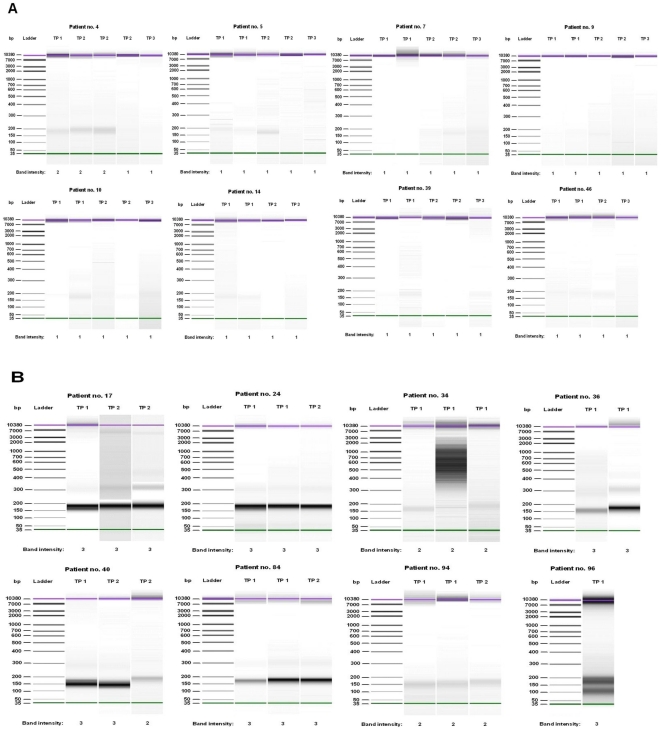
Qualitive cf-DNA analysis.Qualitative analysis of plasma cf-DNA in 8 bacteremia survivors (panel A) and 8 non-survivors (panel B) after NucleoSpin® Plasma XS kit extraction. Analyses were performed with Agilent's High Sensitivity Lab-on-a-chip DNA assay. Green lines indicate the low-weight (35 bp) DNA marker and purple lines the high- weight (10 380 bp) DNA marker. TP 1 = time point 1 (1 to 4 days after blood culture), TP 2 =  time point 2 (5 to 17 days after blood culture), TP 3 = time point 3 (recovery, >25 days after blood culture). The intensity of the low-molecular-weight cf-DNA band was graded as follows: 1 = no visible cf-DNA or weak intensity, 2 = intermediate intensity, 3 = strong intensity. Abbreviations; bp =  base pairs, TP = time point.